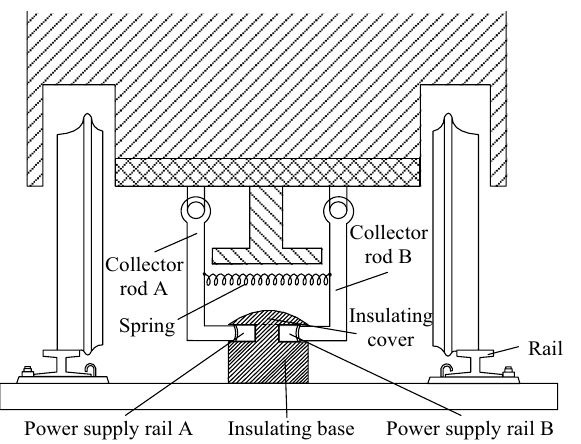
Fig. 2 Schematic diagram of contact power supply system